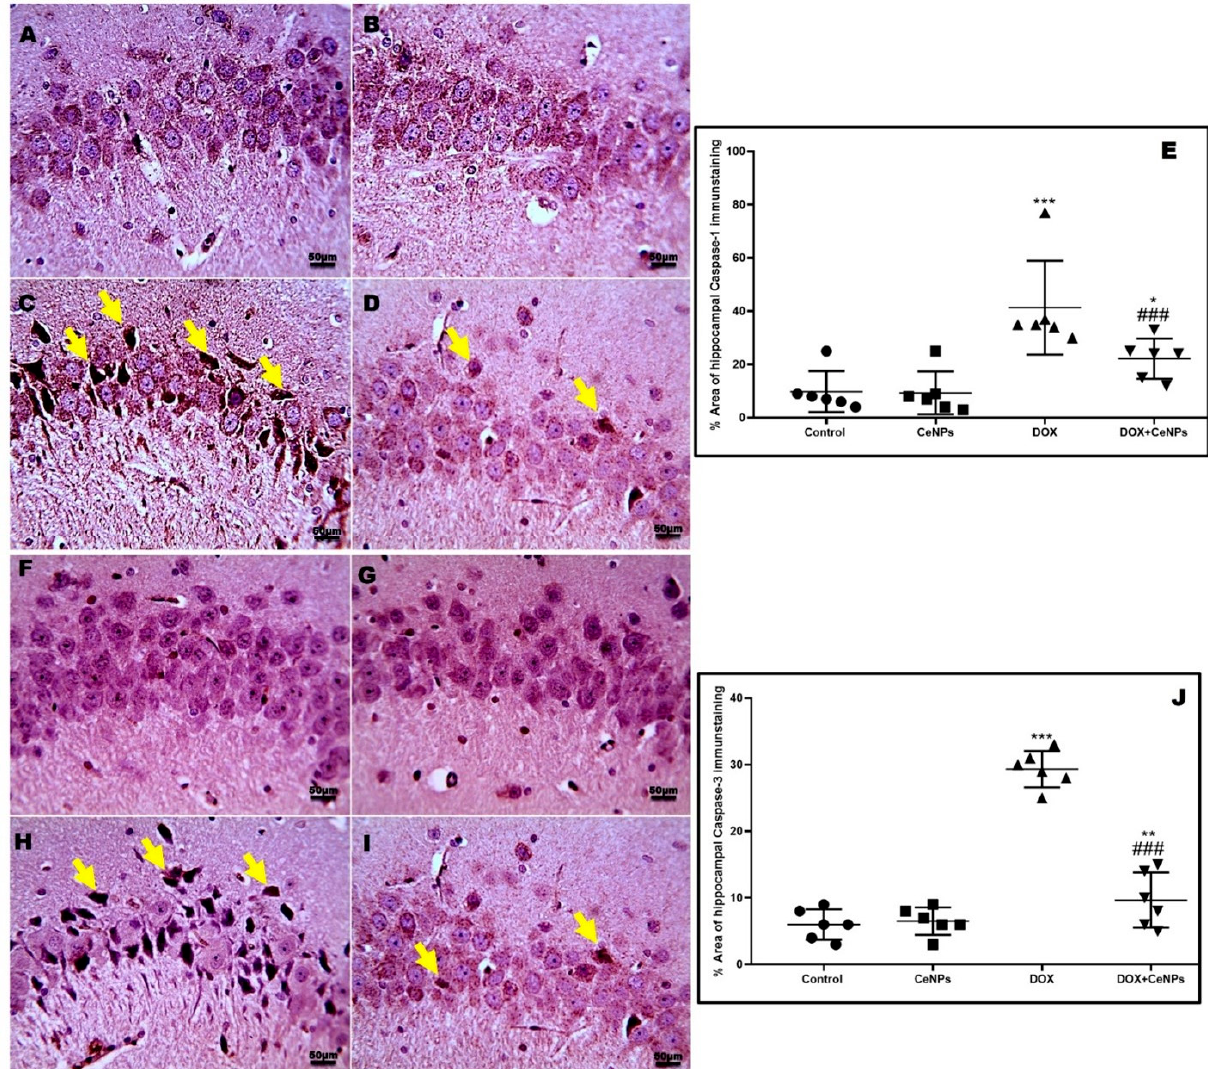
Figure 9. Effect of nanoceria on the hippocampal expression of caspase 1 and caspase 3 enzymes. ( A , B , F , G ) Hippocampal sections of control group and group which received CeNPs showing few numbers of positively brown stained neurons in pyramidal layer in CA3 region. ( C , H ) Hippocampal sections from DOX group showed markedly increased numbers of positively brown stained neurons (yellow arrows). ( D , I ) Hippocampal sections from treated group DOX + CeNPs showed decreased numbers of positively brown stained neurons (black arrows). ( E , J ). Histogram of % area of immunostaining hippocampal caspase 1 and caspase 3, respectively. Values are expressed as mean ± SD. The statistical investigation was carried out utilizing one-way ANOVA with Tukey’s post hoc analysis. *** p < 0.001, ** p < 0.01, and * p < 0.05 significant vs. control group ### p < 0.001 significant vs. DOX group. Magnification ×400. Scale bar = 50 μ m.